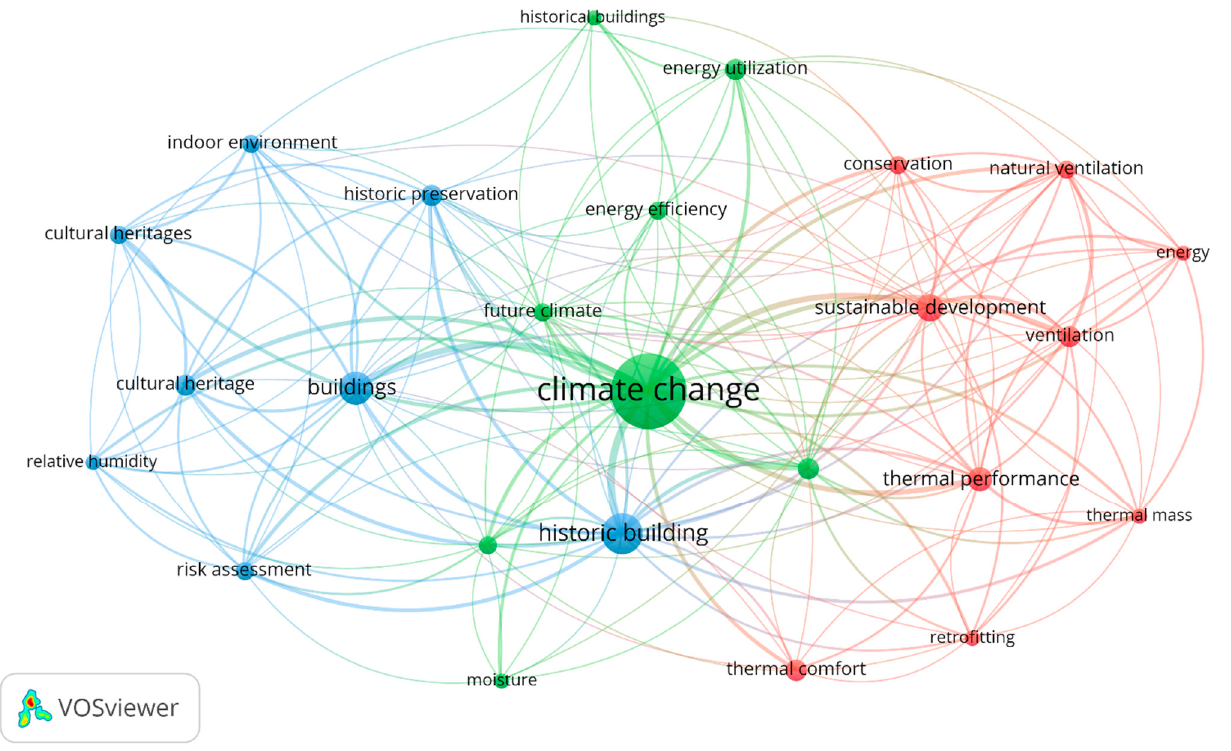
Figure 10. Co-occurrence analysis of all the keywords (network visualization).